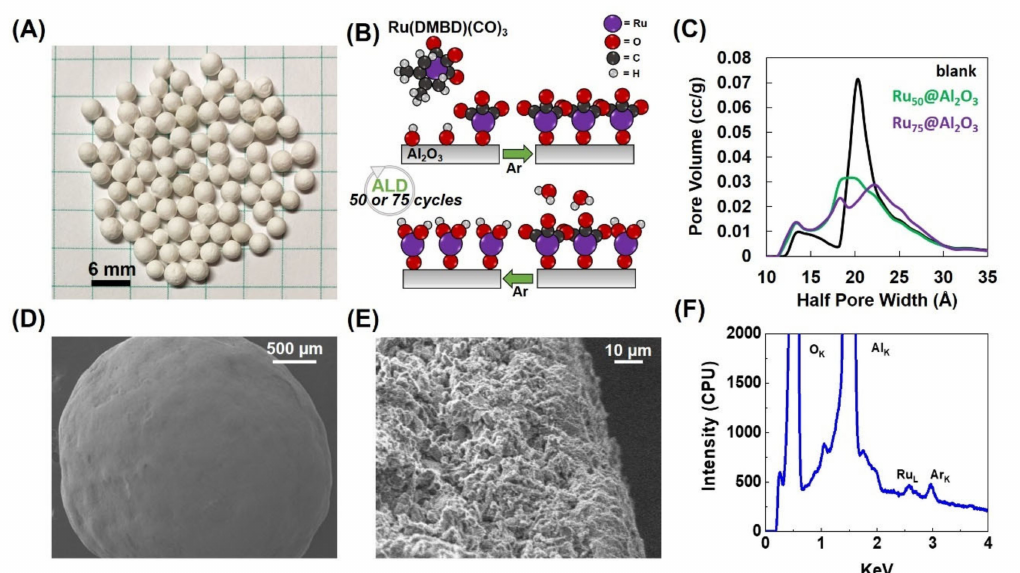
Figure 1. Blank Al 2 O 3 spheres ( A ); schematic representation for atomic layer deposition (ALD) growth of Ru film ( B ); pore volume ( C ); Scanning Electron Microscopy (SEM) micrographs ( D , E ); Energy Dispersive X-ray analysis (EDX) of Ru 75 @Al 2 O 3 ( F